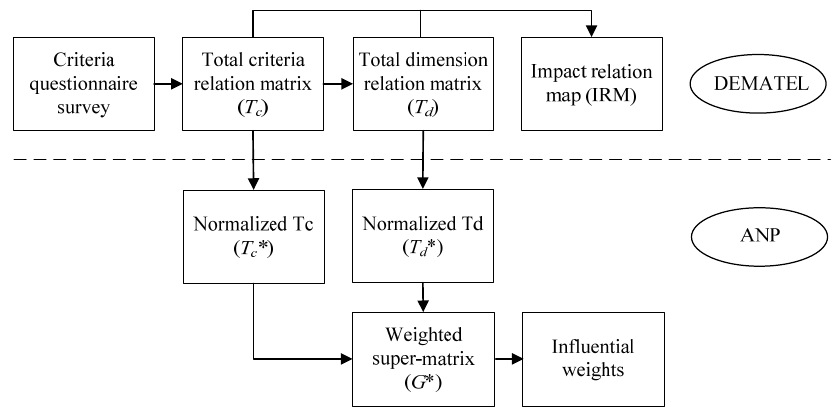
Figure 1. Process flow of the Decision Making Trial and Evaluation Laboratory–based analytical network process (DANP) model.